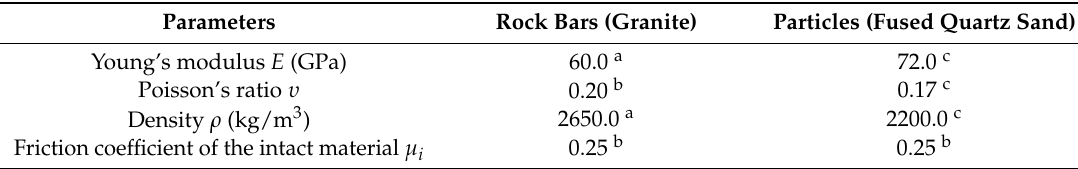
Table 1. Macro properties of the FDEM model.